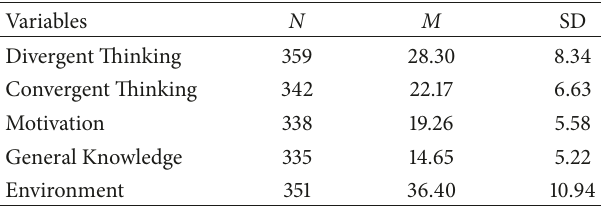
Table 2: Mean, SD, and n among the students’ responses on five subscales and CPSAI total